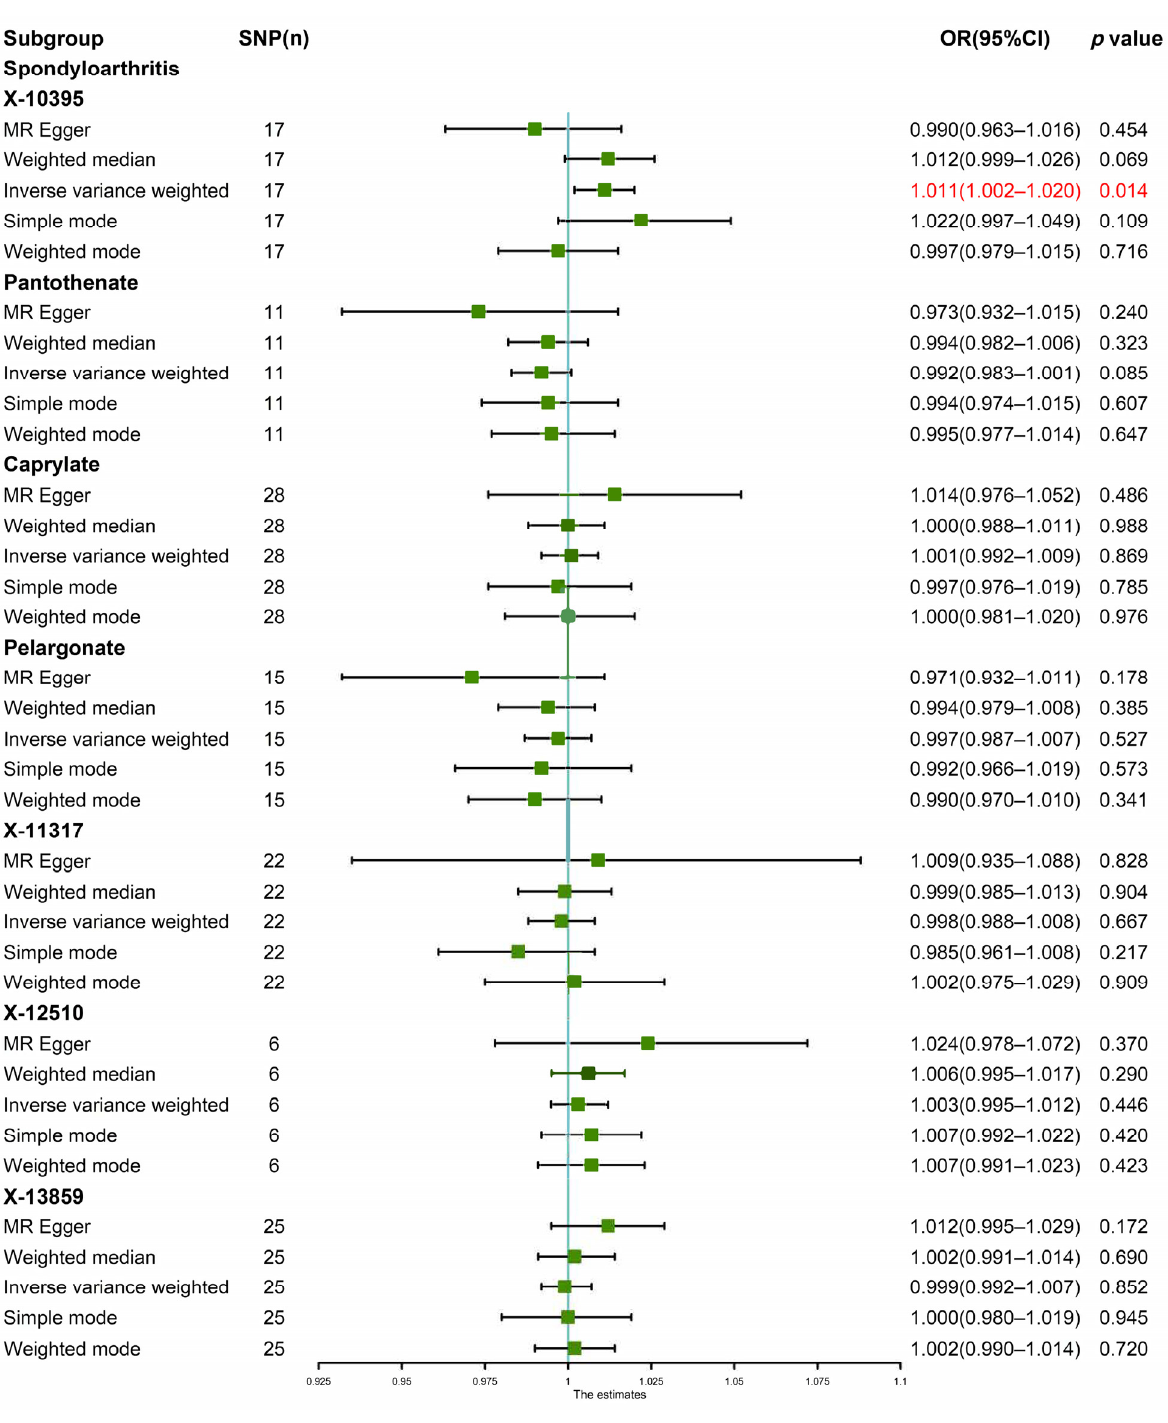
Figure 2. MR analysis results of the blood metabolites (X-10395, pantothenate, caprylate, pelargonate, X-11317, X-12510, and X-13859) and spondyloarthritis. Five methods: random-effects IVW, MR Egger, weighted median, simple mode, and weighted mode. The red part of the figure is the results that had genetic causal relationship.